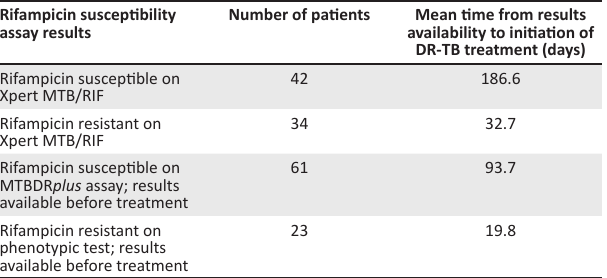
TABLE 2: Time from availability of results to initiation of drug-resistant tuberculosis treatment in patients with M. tuberculosis isolates with